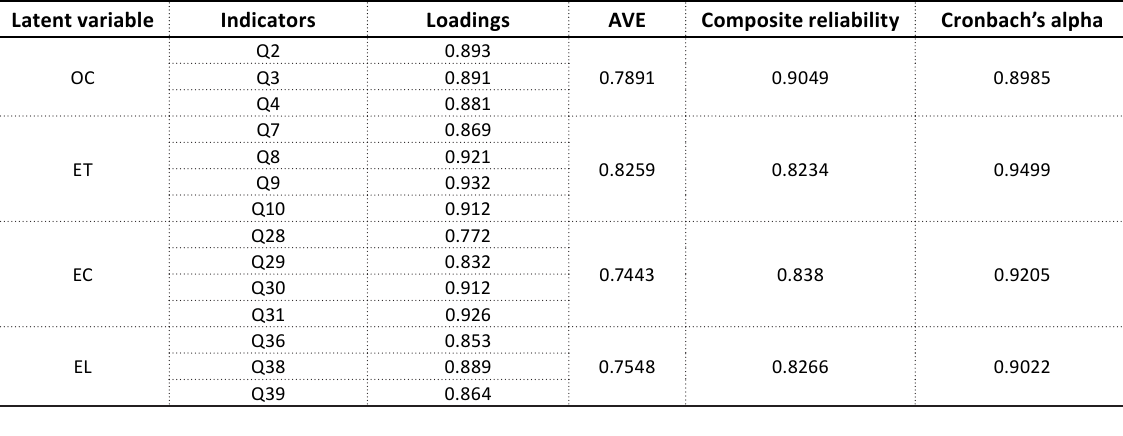
Table 2. AVE, CR, Cronbach’s alpha and loading details